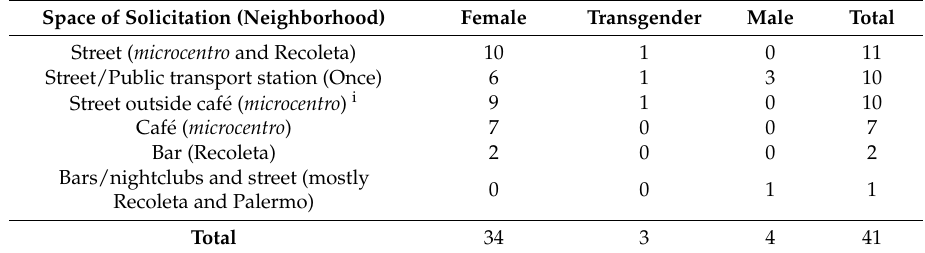
Table 1. Sex worker participant spaces of solicitation in Buenos Aires, Argentina by gender. Space of Solicitation (Neighborhood) Female Transgender Male Total Street ( microcentro and Recoleta) 10 1 0 11 Street/Public transport station (Once) 6 1 3 10 Street outside caf é ( microcentro ) i 9 1 0 10 Caf é ( microcentro ) 7 0 0 7 Bar (Recoleta) 2 0 0 2 Bars/nightclubs and street (mostly 0 0 1 1 Recoleta and Palermo) Total 34 3 4